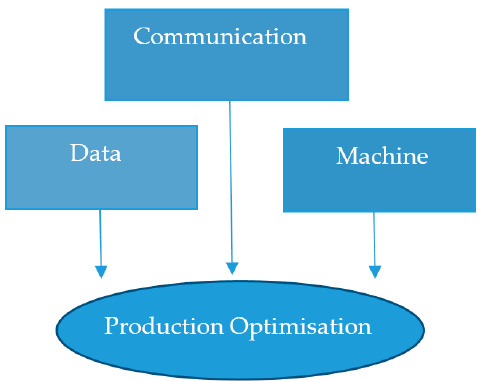
Figure 6. Key components of the project: Digitalization of enterprise. Source: own study. Proposals for innovativeness in the scope of work carried out by machines are im- plemented non-stop. The machine learning project (carried out at the start-up phase) involves the start-up of machine learning elements and the use of current data processing algorithms to enable production machines to learn. The scope of machine learning concerns the optimization of